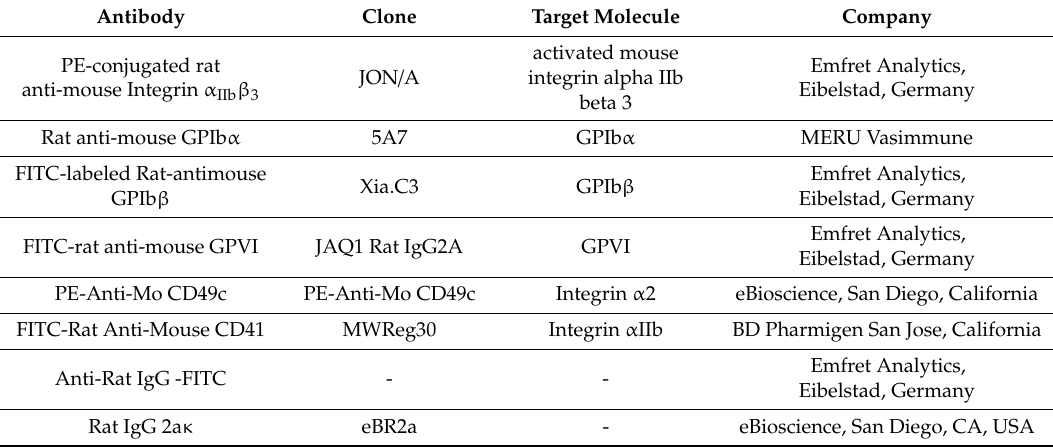
Table 1. List of